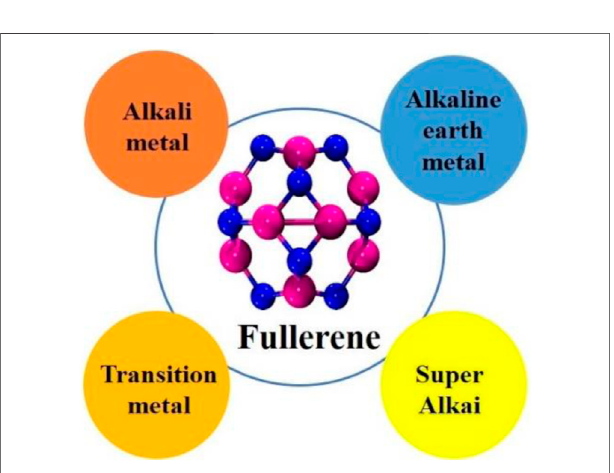
FIGURE 8 | Excess electron-based dopants for